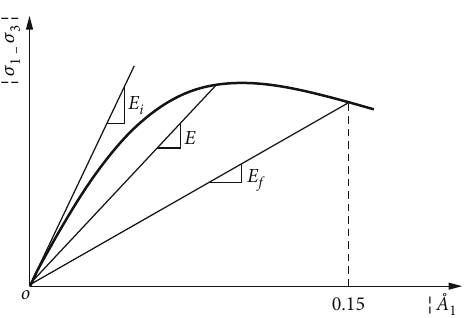
Figure 8: Illustration for determination of damage parameters.